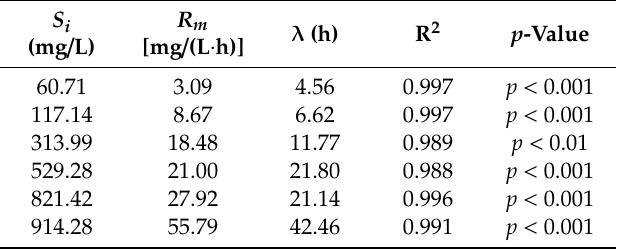
Figure 4. Fitting of Rhodococcus sp. SKC growth at different concentrations using the modified Gompertz model ( a ): 60.71 mg / L, ( b ): 117.14 mg / L, ( c ): 313.99 mg / L, ( d ): 529.28 mg / L, ( e ): 821.42 mg / L, ( f ): 914.28 mg / L. The arrow: the lag time (h). Table 1. Parameters and R 2 using the Gompertz model on the substrate.